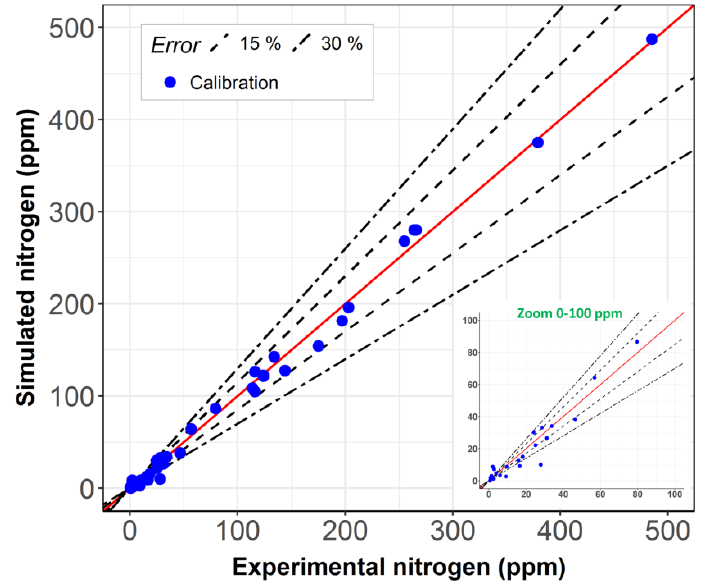
Figure 1. Parity diagram of the best scenario (calibrating steady-state model with 38 steady-state